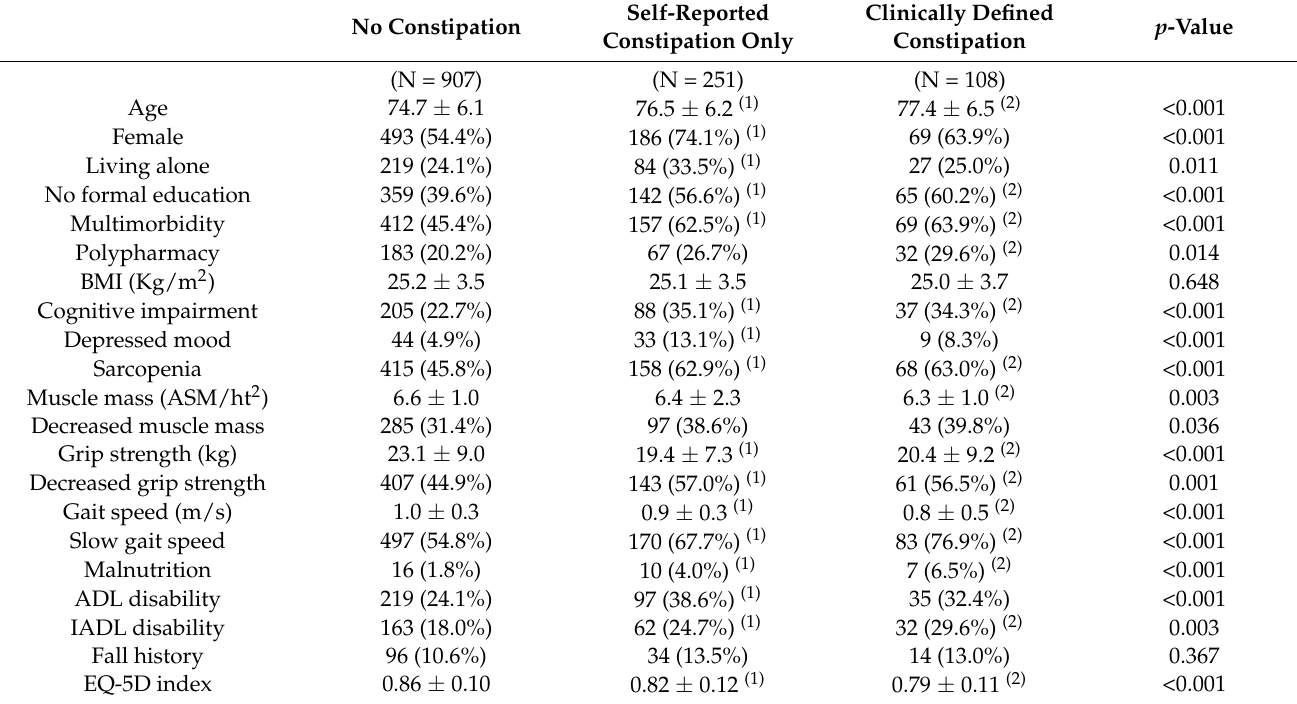
Table 3. Participant characteristics according to constipation status.